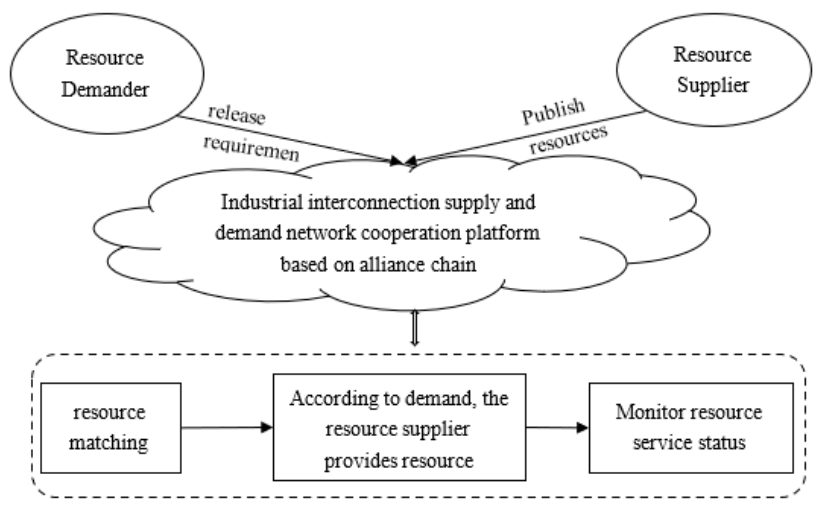
Figure 1. The cooperation framework of the industrial interconnection supply and demand network based on the Alliance blockchain platform.